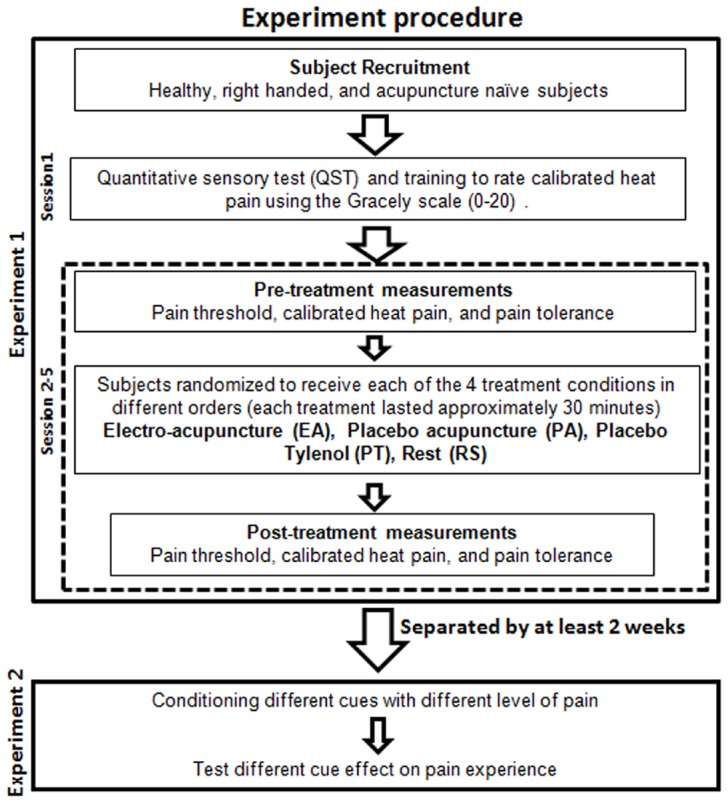
Experimental design.